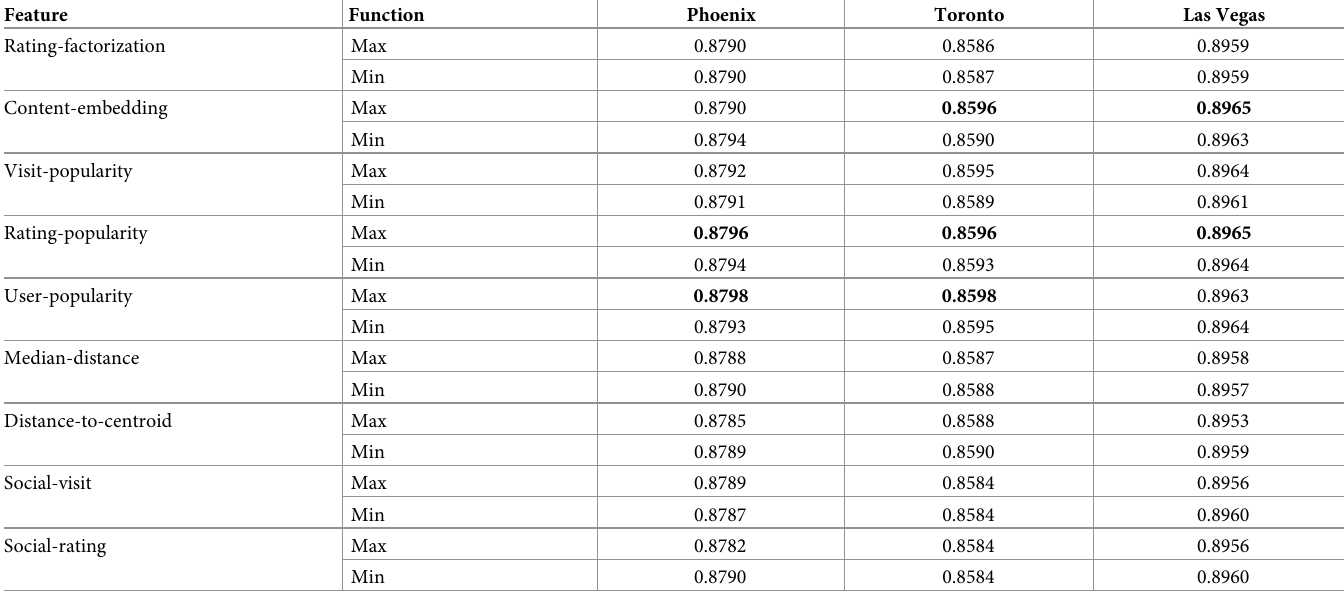
Table 4. AUC for FastTree on each user-POI feature with maximum (minimum) aggregating functions.